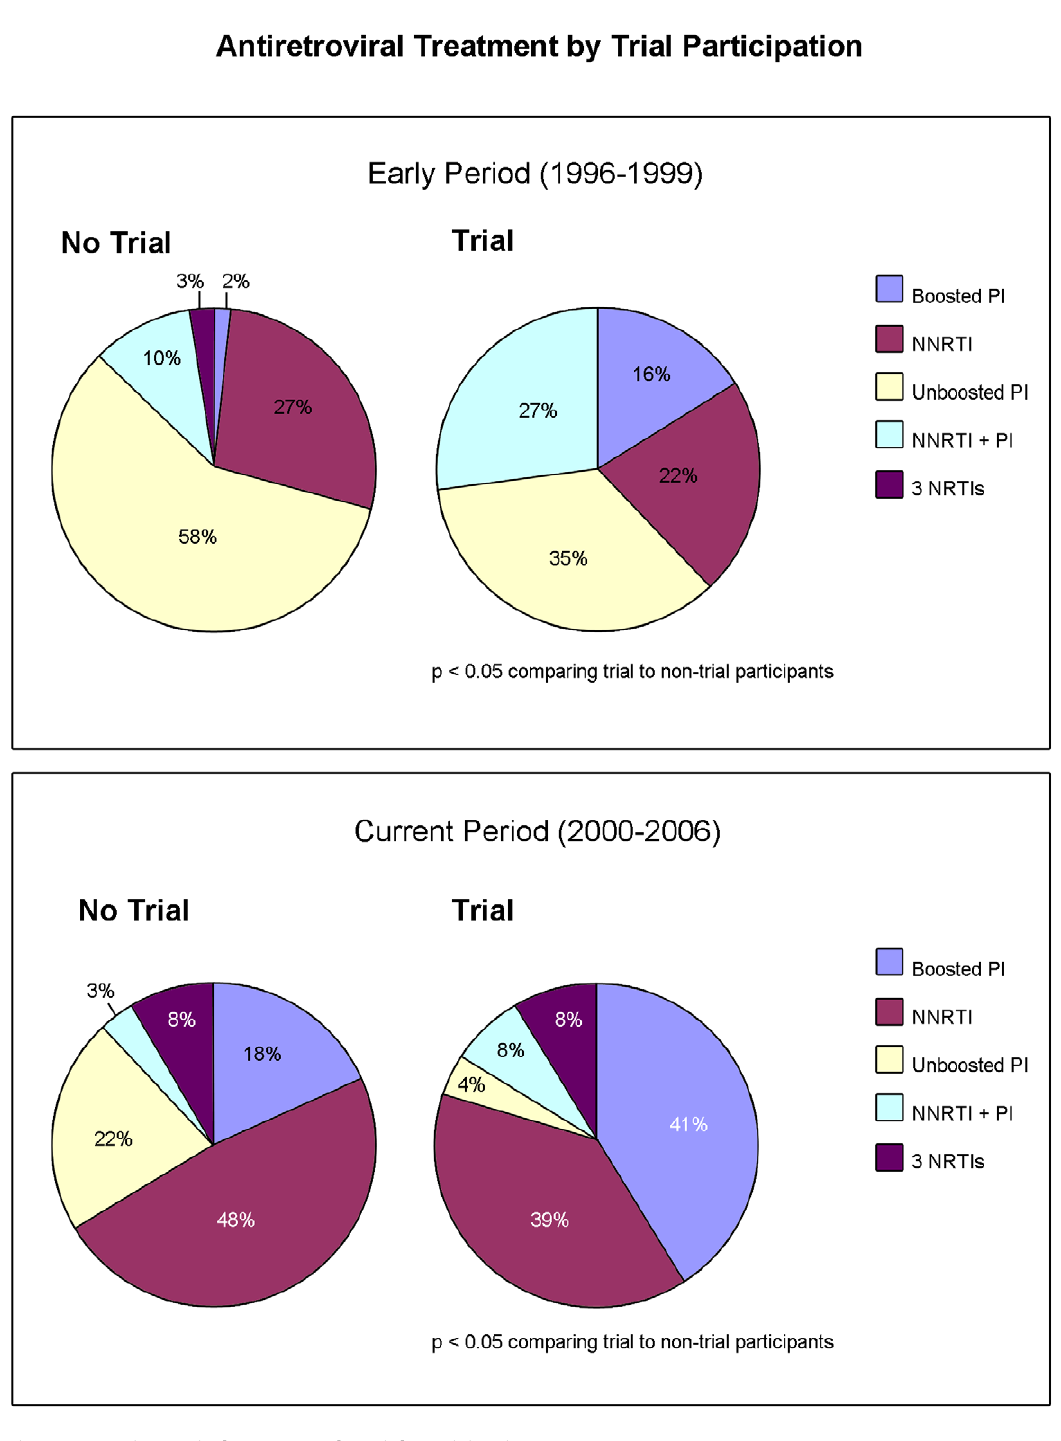
Figure 1. Antiretroviral treatment by trial participation.